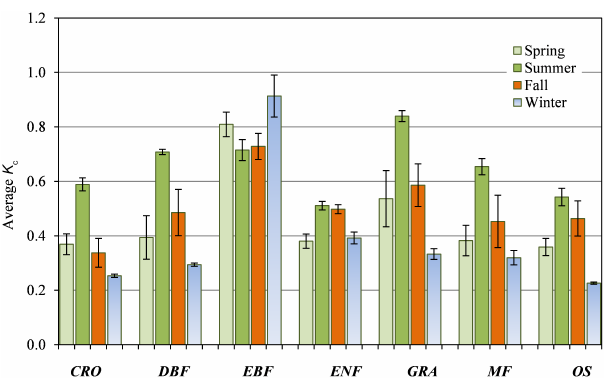
Figure 3. Average K c in spring, summer, fall, and winter in dif- ferent vegetation types. The error bars are standard errors among different sites. Spring is the months of February, March, and April;